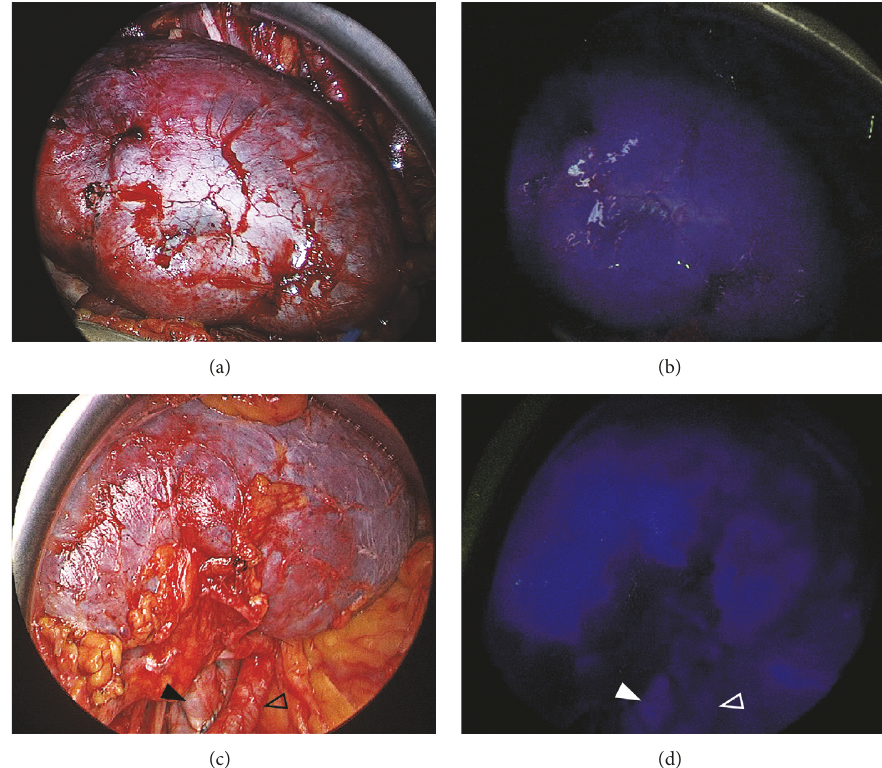
Figure 1: Intraoperative fluorescence imaging using indocyanine green (ICG) . Images taken after completion of vascular anastomosis, and after 1-minute following intravenous ICG administration. (a-b) Homogenous global fluorescence observed in graft kidney. (c-d) ICG fluorescence demonstrated in the vessels alongside homogenous graft fluorescence (open arrow represents renal artery; closed arrow represents renal